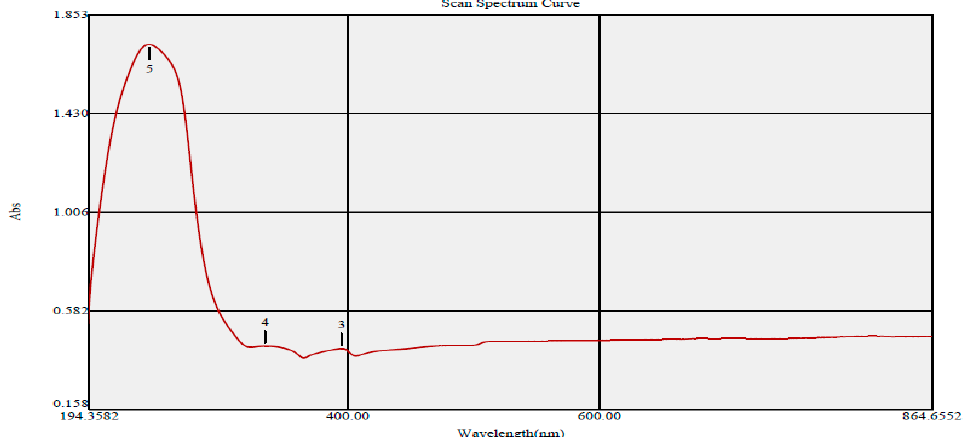
Figure 3. UV-vis spectrum of the biogenic AgNPs formulated using S. officinalis extract (peak 3: 395 nm; peak 4: 334 nm; peak 5: 242).